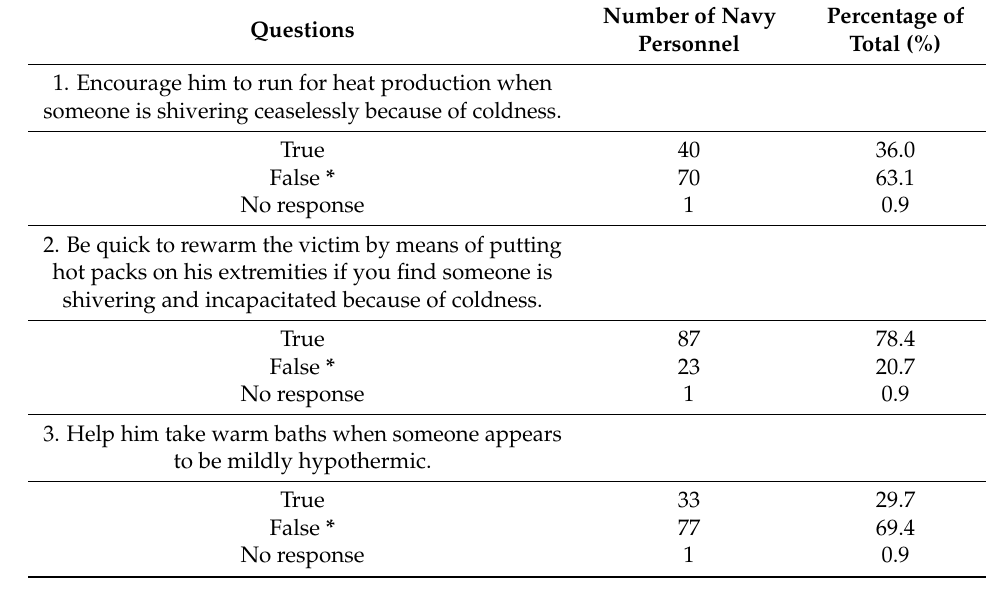
Table 3. Treatments of hypothermia ( n =